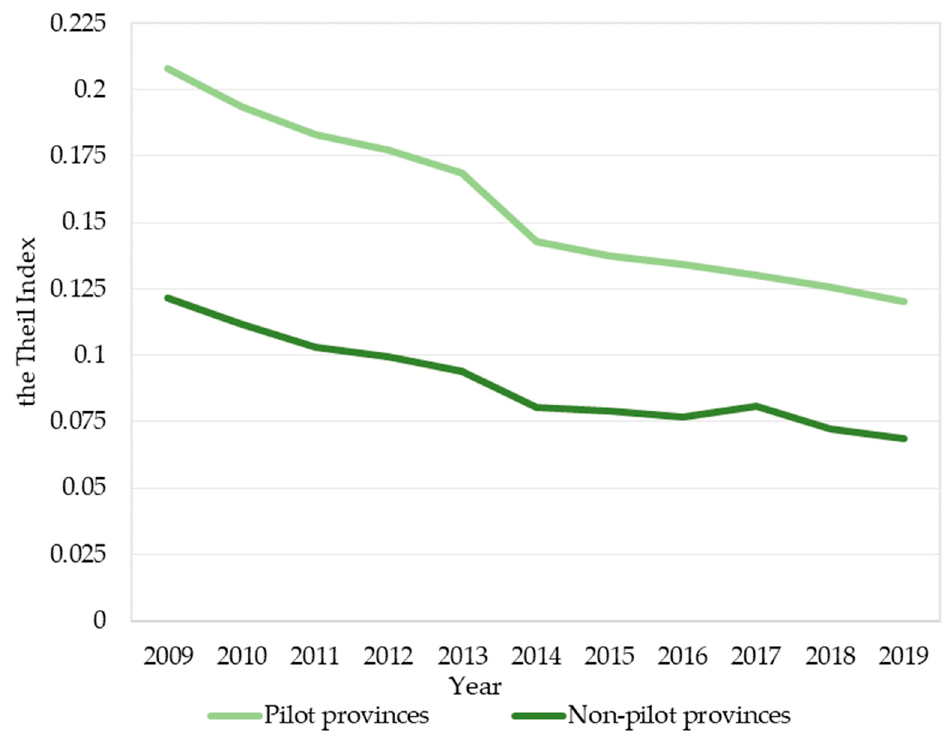
Figure 5. The trend of the urban–rural income gap between pilot and non-pilot provinces. Note: Derived from independent calculations.